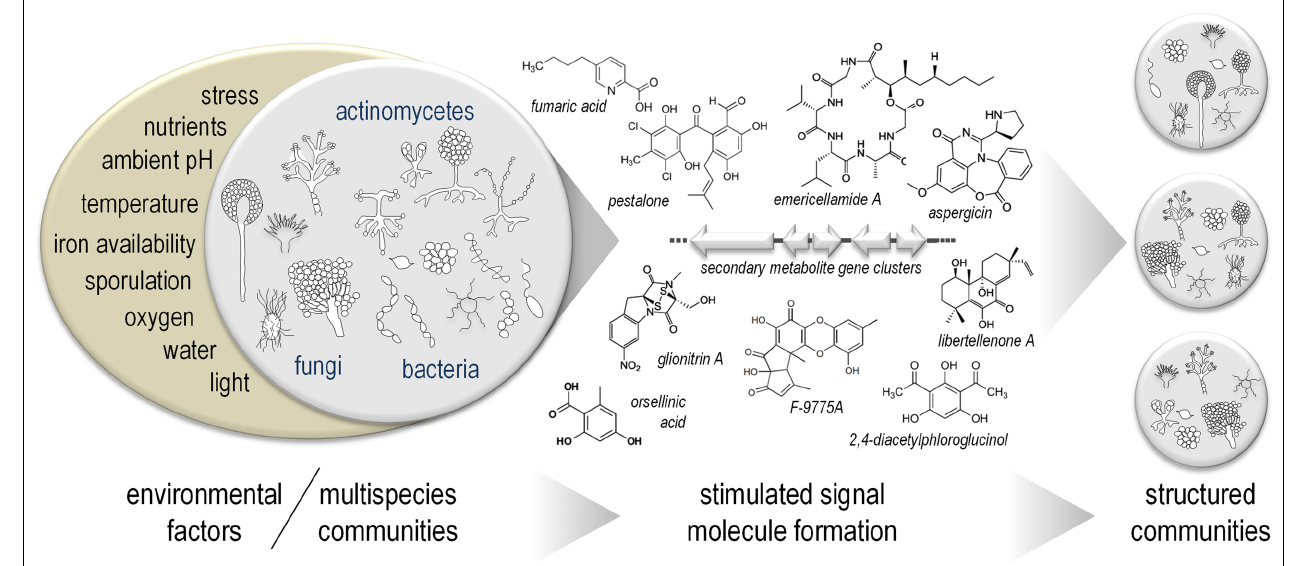
FIGURE 1 | Microorganismic multispecies communities form secondary metabolites that contribute to the stabilization/changes in these companionships . In nature, microorganisms process signals from both abiotic and biotic environments. The latter represent secondary metabolites or natural